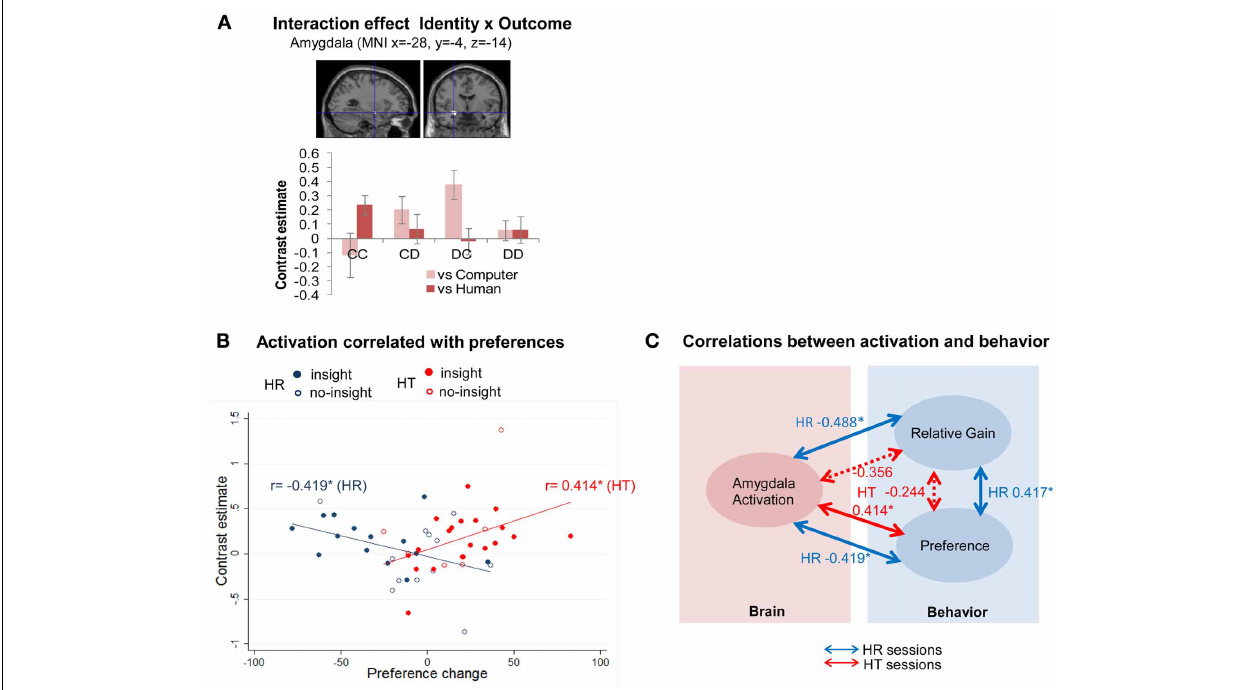
insight are indicated by hollow circles. The solid blue and red lines represented the fitted regression line of all cases, i.e., those with and without insight in HR and HT, respectively. (C) Individual activation in the amygdala was negatively correlated with an individual’s relative gain (subject’s session score/partner’s session score) against a human partner following a random strategy (HR) ( r = − 0 . 488, p = 0 . 012), whereas no statistically significant correlation was observed when playing with a human following a tit-for-tat strategy (HT) ( r = − 0 . 356, p = 0 . 075). Note that a partial correlation between activation of the amygdala and relative gain was not statistically significant ( r = − 0 . 272, p = 0 . 189) in the HR session when the effect of preference change was controlled. Dotted lines represent correlations that were not statistically significant. ∗ p < 0 . 05.